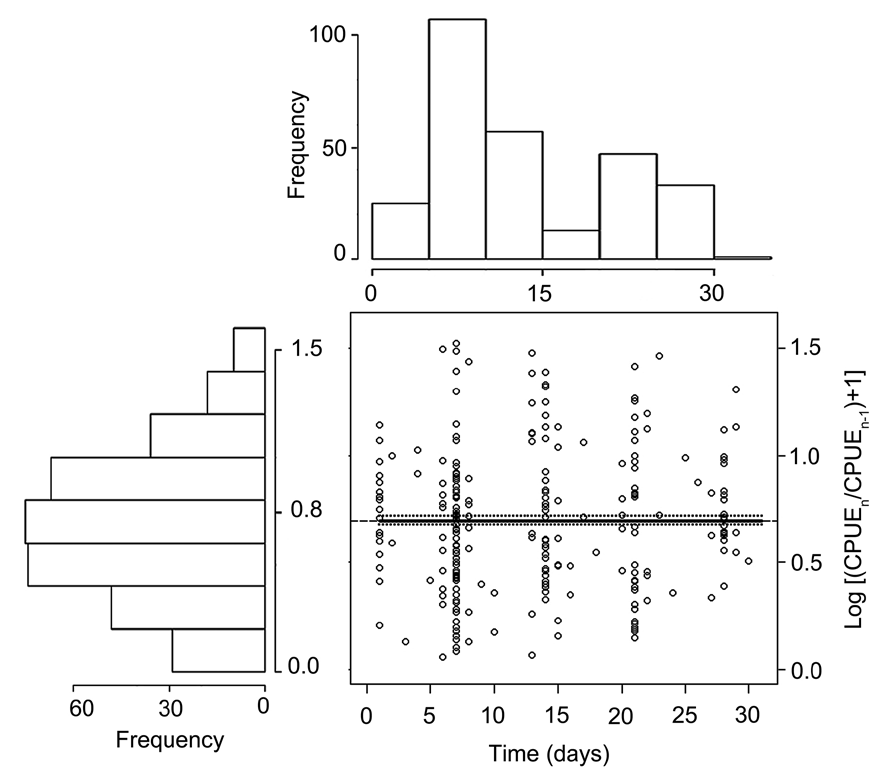
Fig. 2. – Partial effect of the time between pairs of competitions held in the same area (one month maximum) on the rate of change of the CPUE (logarithmic scale) between 1964 and 2007. The observations (points), the prediction (continuous lines) and their standard deviation (dashed lines) estimated by GAM are shown. Histograms of the frequencies of the two variables are also